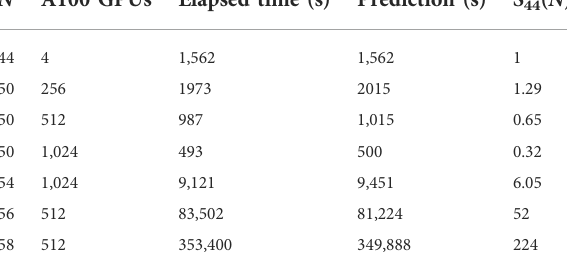
TABLE 1 Strong- and weak-scaling results for QUBO22 using NVidia A100 GPUs. The second column gives the number of GPUs used and the third column lists the elapsed time to